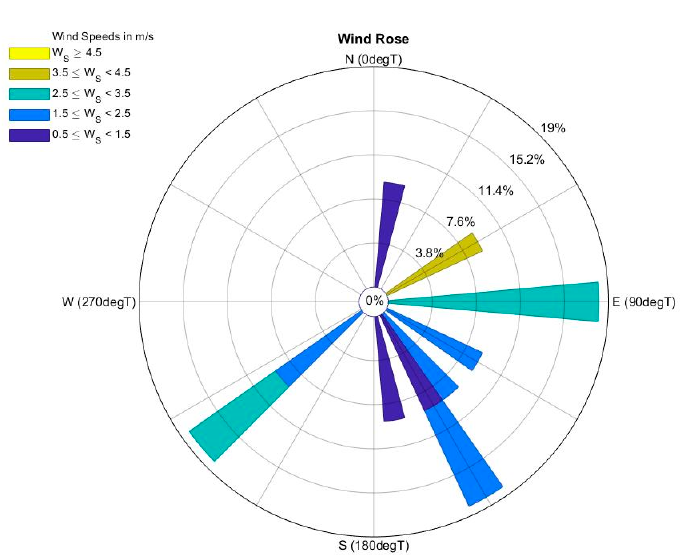
Figure 2. Rose plot indicating the direction (DegT) and speed (m/s) of wind using the data from the meteorological monitoring station run by NIWA (Motat EWs station). meteorological monitoring station run by NIWA (Motat EWs